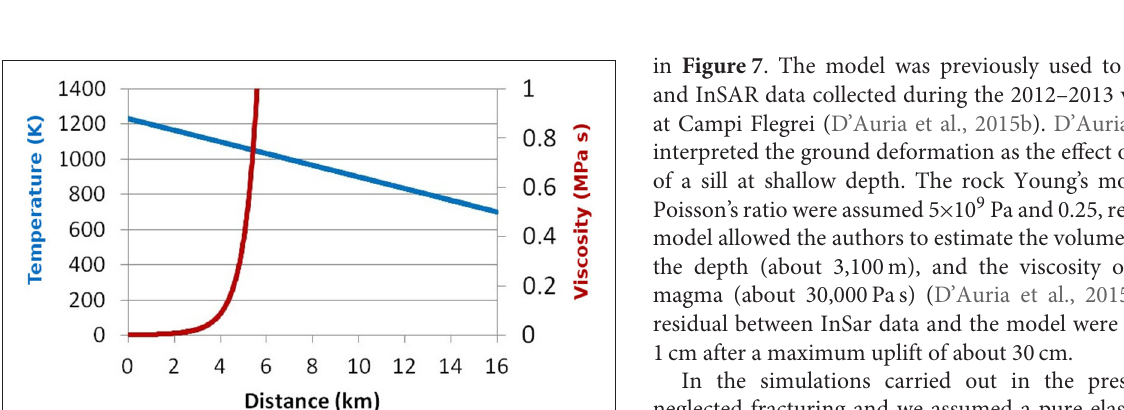
FIGURE 11 | Maximum uplift (blue, left axis) and maximum stress (red, right axis) obtained in the simulations with high magma viscosity-low rock Young’s modulus (FELSIC) and low magma viscosity-high rock Young’s modulus (MAFIC) compared with the reference case (REF). For parameter setting see Table 2 .